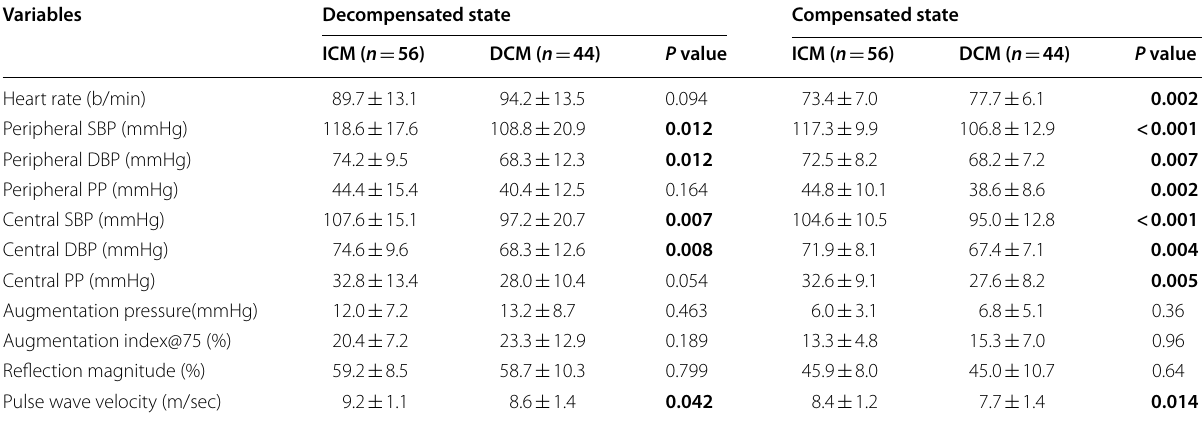
Significant P value (<0.05) is presented in bold Data are presented as mean DBP, diastolic blood pressure; PP, pulse pressure; SBP, systolic blood pressure